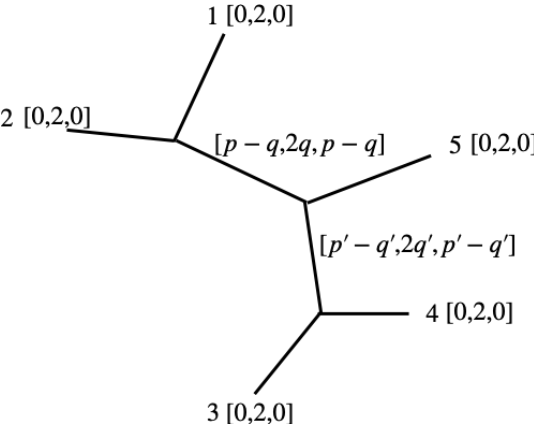
Figure 8. An R-symmetry channel of the 20 0 (cid:12)ve-point function where the representation [ p (cid:0) q; 2 q; p (cid:0) q ] is exchanged in 12 and the representation [ p 0 (cid:0) q 0 ; 2 q 0 ; p 0 (cid:0) q 0 ] is exchanged in